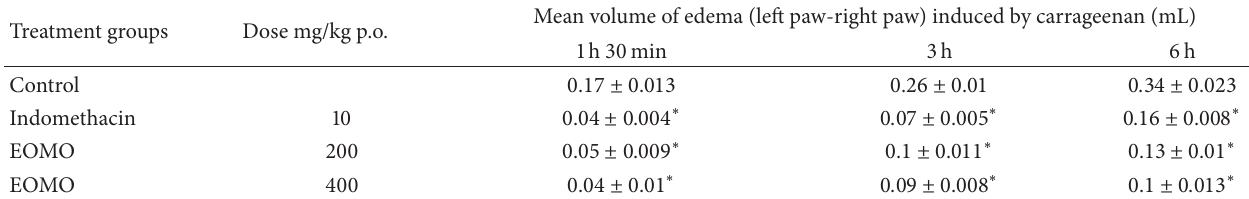
Table 1: Effect of essential oil of Melissa officinalis L. on carrageenan-induced rat paw edema. Treatment groups Dose mg/kg p.o.